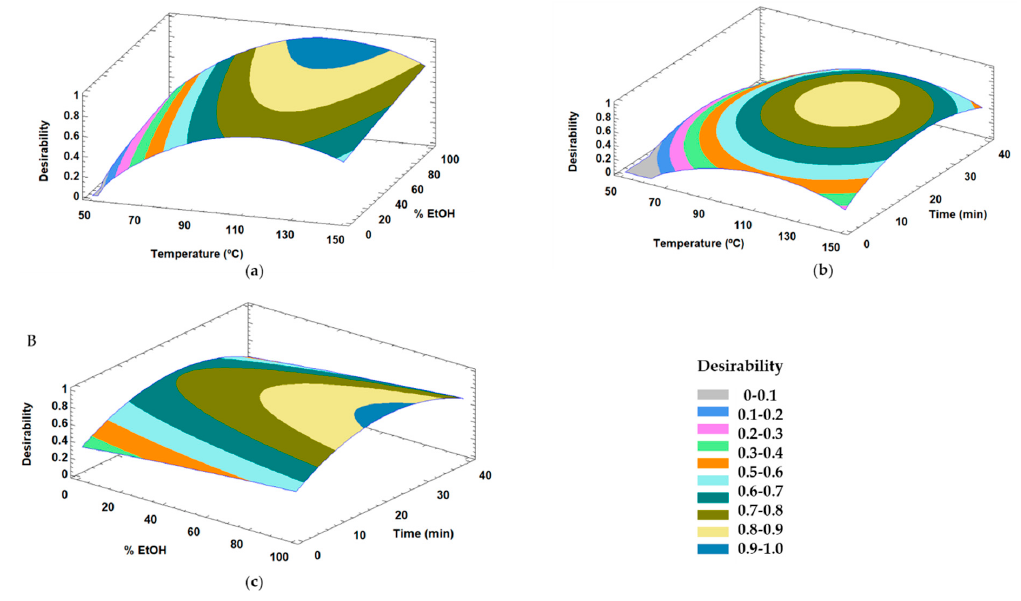
Figure 4. Response surface plots showing combined effects of process variables for desirability in total compounds and total AMPK bioactive compounds: Temperature (°C)–% EtOH ( a ), Temperature (°C)–time (min) ( b ) and % EtOH–time (min) ( c ).